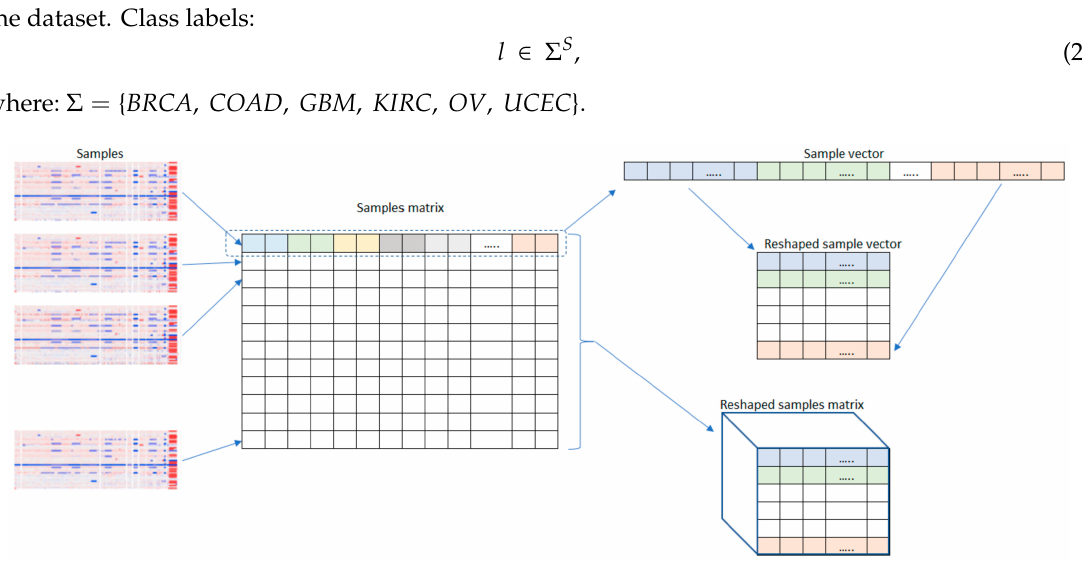
Figure 1. Data preparation